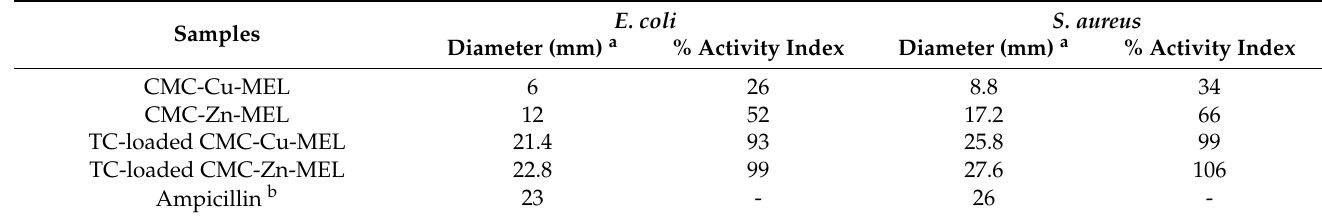
Table 1. The antibacterial activity of the TC-loaded CMC-Cu-MEL and TC-loaded